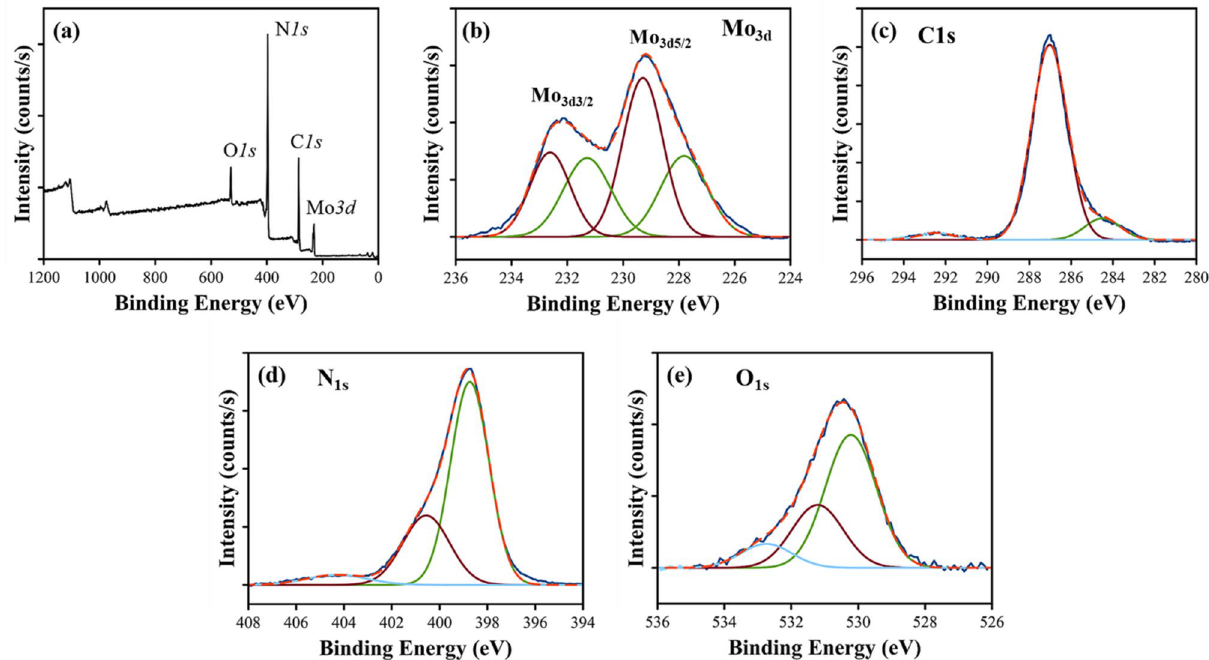
Figure 5. X-ray photoelectron spectroscopy: ( a ) XPS survey scan of 5%Mo-CN nanotubes; and (b-e) the core-level XPS spectra of ( b ) Mo3d, ( c ) C1s, ( d ) N1s, and ( e ) O1s showing the chemical state and speciation of different